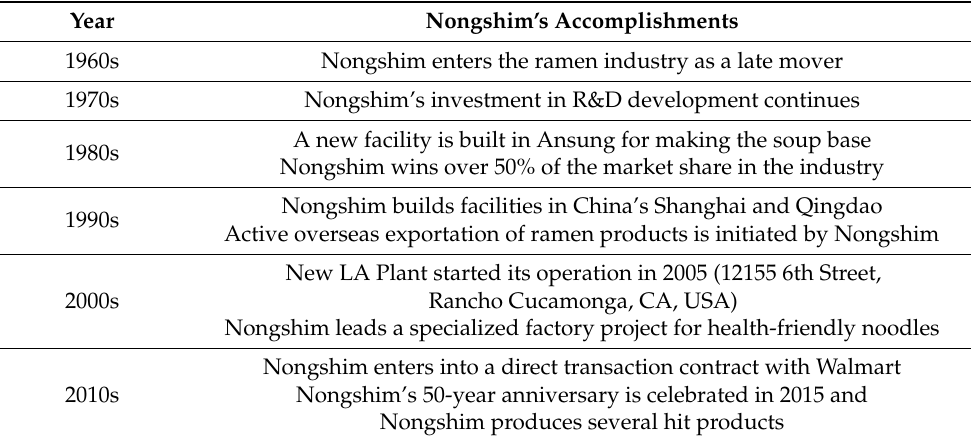
Table 2. Nongshim’s history throughout 1960s until the